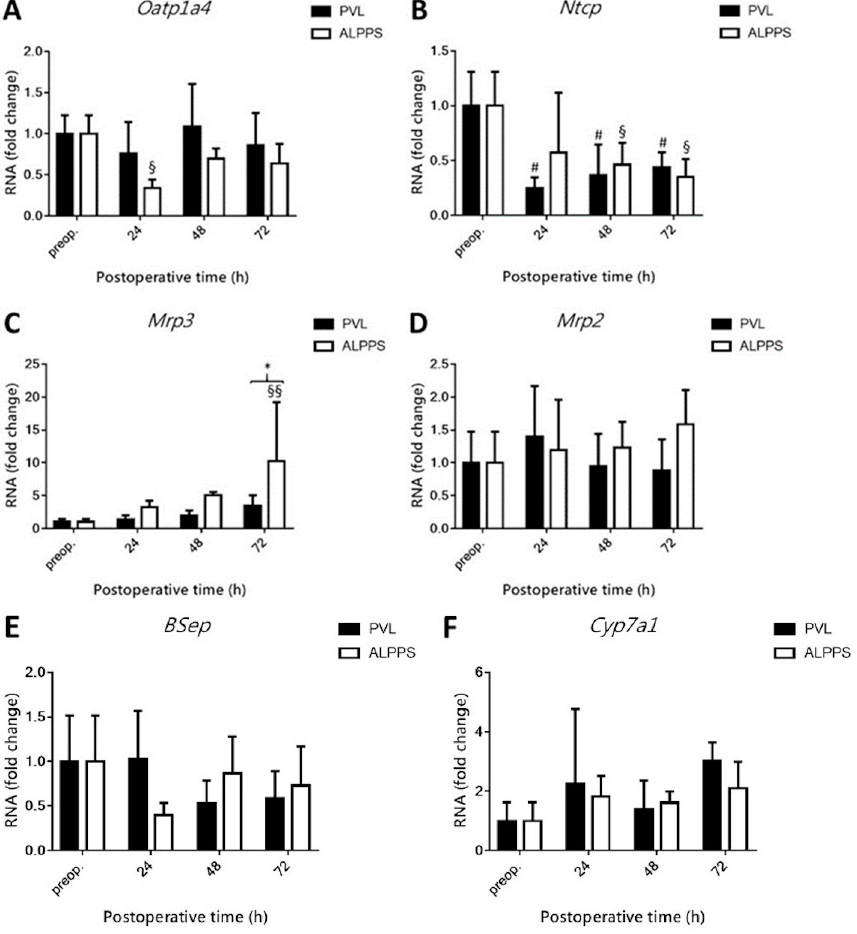
Figure 6. Effect of portal vein ligation (PVL) and associating liver partition and portal vein ligation for staged hepatectomy (ALPPS) on mRNA levels of hepatic bile acid production enzymes and transporters. Transcript levels of Oatp1a4 ( A ), Ntcp ( B ), Mrp3 ( C ), Mrp2 ( D ), Bsep ( E ), and Cyp7a1 ( F ) were determined preoperatively (preop.) and at 24 h, 48 h, 72 h, and 168 h after PVL and ALPPS ( n = 6 per time point per group). * p < 0.05, # p < 0.05 PVL versus corresponding controls (preop.); § p < 0.05, §§ p < 0.001 ALPPS versus corresponding controls (preop.). Statistical analysis was performed with a two-way ANOVA and Tukey’s post hoc test. Data are presented as mean ± 1 standard deviation (SD).